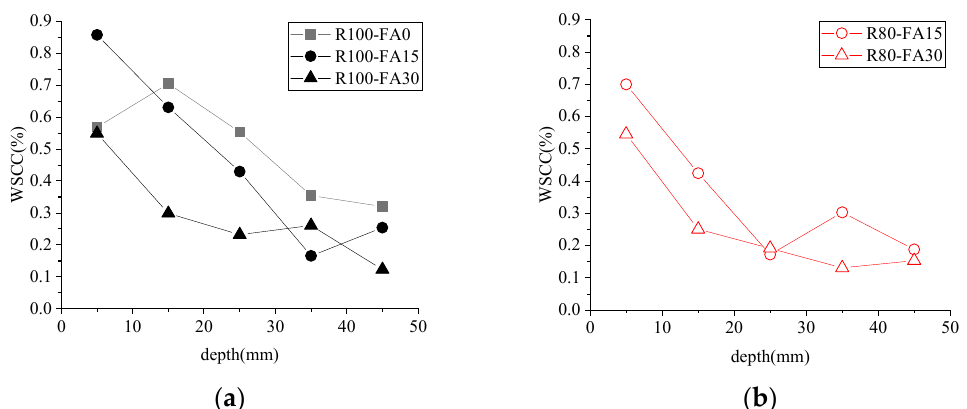
Figure 11. Influence of fly ash content on WSCC. ( a ) R100, ( b ) R80. Note—R is for recycled brick- concrete aggregate; numbers are the value of replacement rate (%).